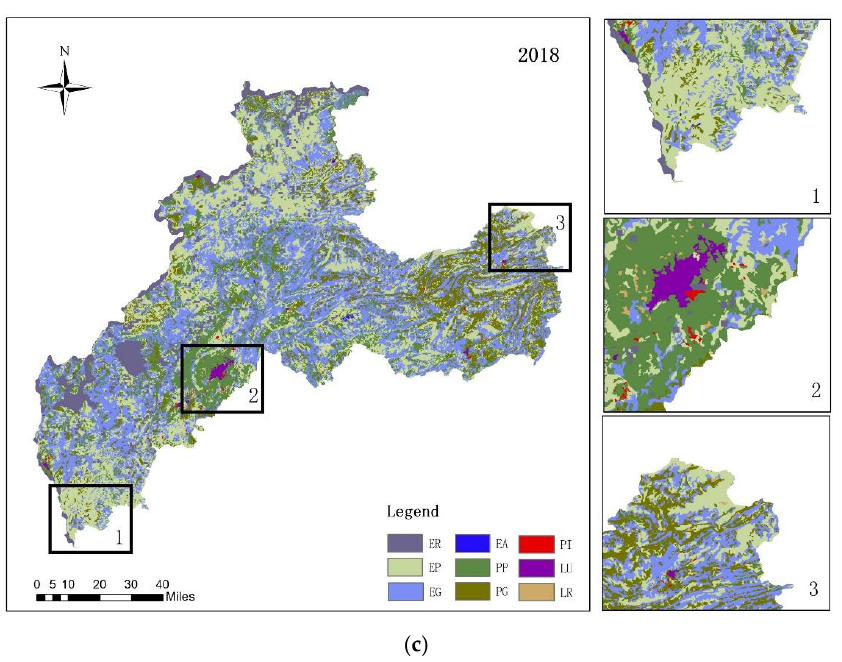
Figure 5. ( a – c ) represent the spatial distribution of PLE space in 2010, 2015, and 2018, respectively.ER is restricted ecological space. EP is priority ecological space. EG is general ecological space. EA is accommodated ecological space. PP is priority agricultural production space. PG is general agricultural production space. PI is industrial production space. LU is urban living space. LR is rural living space.